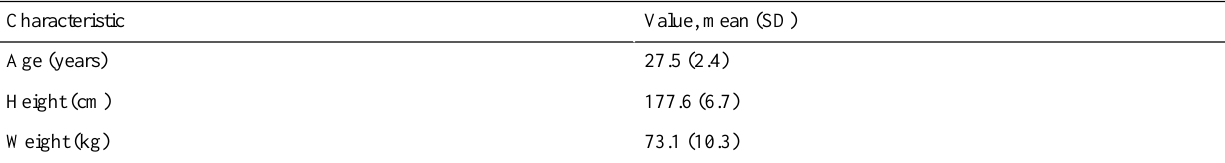
Table 1. Demographic characteristics of the participants in the study (N=15).